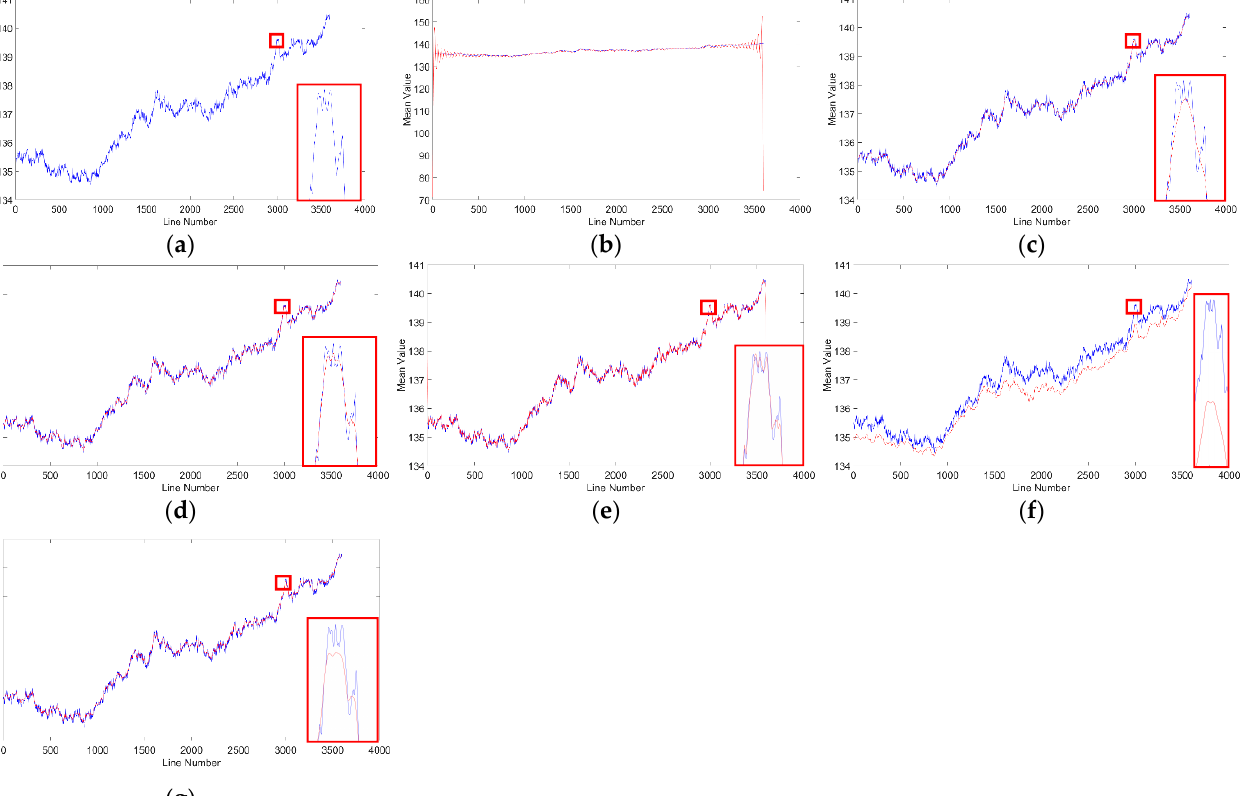
Figure 11. Mean cross-track profiles of the results of the real experiment for area S31E147 (unit: meter). ( a ) Area S31E147, ( b ) low-pass filter, ( c ) TV, ( d ) UTV, ( e ) LRSID, ( f ) Gallant and ( g ) LRGS.